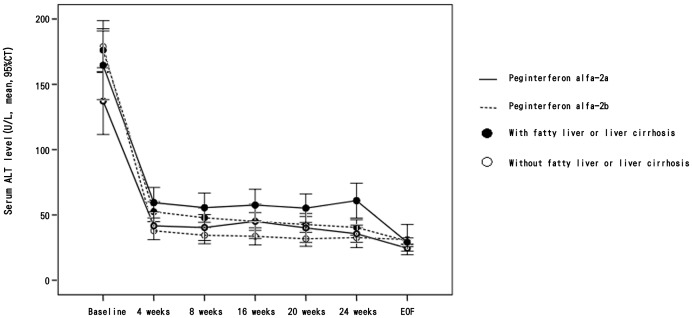
Serum ALT levels in patients achieving a SVR during treatment and 24 weeks post-treatment (EOF) based on treatment medication and underlying liver disease.